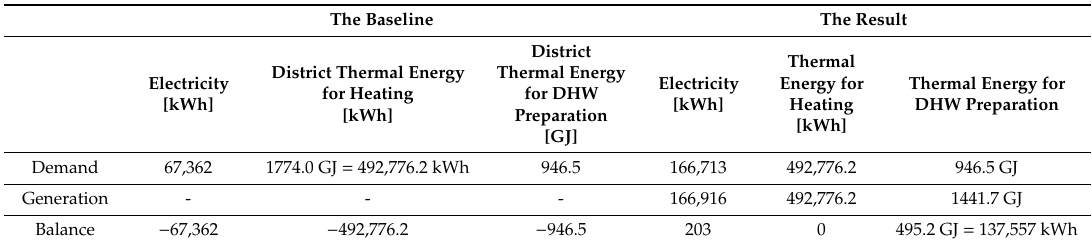
Table 5. Energy demand and generation before and after installation of the RES systems.